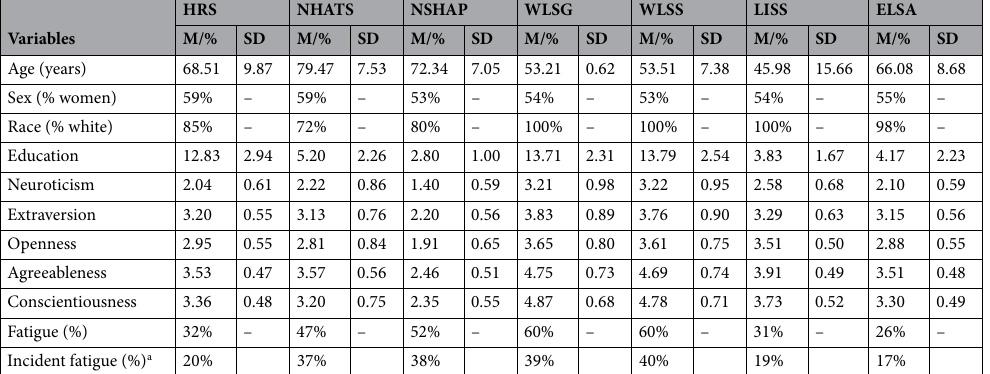
Table 1. Baseline characteristics of the samples. HRS: N = 12,364; NHATS: N = 2760; NSHAP: N = 2062; WLSG: N = 6590; WLSS: N = 3356; LISS: N = 5796; ELSA: N = 8078. a Individuals who reported fatigue at baseline were